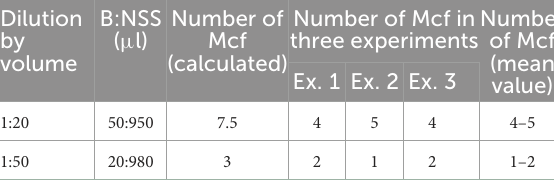
After experimentation, the number of microfilariae trapped inside the microfluidic chip was counted. Results are from three replicates (B, blood; NSS, normal saline;